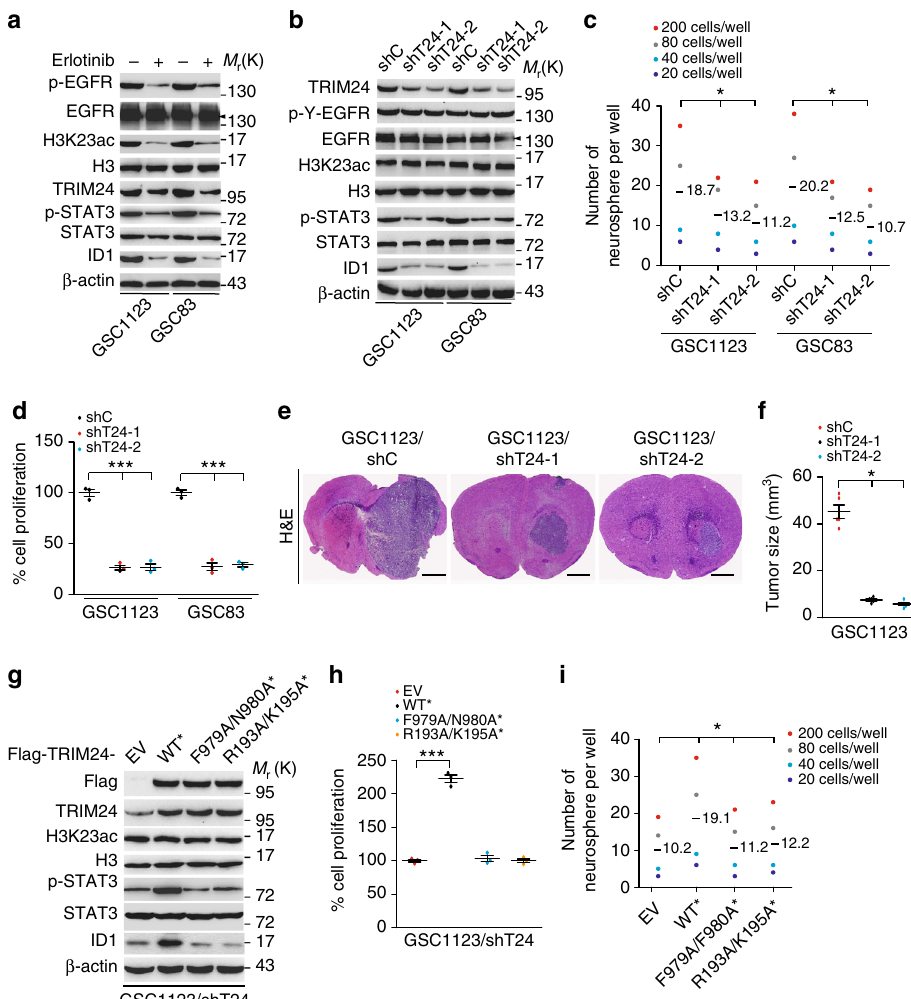
Fig. 8 H3K23ac/TRIM24/STAT3-ID1 axis mediates EGFRvIII-driven glioma stem cell proliferation and self-renewal. a Effects of EGFRvIII on expression of H3K23ac, TRIM24, ID1, STAT3 and p-STAT3. GSC1123 and GSC83 GSCs were treated with Erlotinib (10 μ M) for 24h. β -Actin, EGFR or p-EGFR was used as a control. Arrow heads, EGFRvIII. b Knockdown of TRIM24 inhibits ID1 expression and STAT3 phosphorylation, but not H3K23ac expression, in GSC1123 and GSC83 GSCs. c Limiting dilution neurosphere-forming assays measuring the effects of TRIM24 knockdown. d Cell proliferation assays of effects of TRIM24 knockdown. e Representative images of H&E, analyses of brain sections, with indicated GSC1123 GSCs. Images represent results of 5 mice per group of 2 independent experiments. Scale bars: 1mm. f Quanti fi cation of tumor size. Data were from stained brain sections of 5 mice per group of 2 independent experiments. g , h Effects of re-expression of Flag-TRIM24 shRNA-resistant TRIM24 WT* , TRIM24 F979A/N980A* mutant, TRIM24 R193A/K195A* mutant or an empty vector control (EV) on expression of H3K23ac, STAT3, ID1 and p-STAT3 ( g ) and cell proliferation ( h ) in GSC1123/shT24 GSCs. i Limiting dilution neurosphere-forming assays of effects of re-expression of Flag-TRIM24 shRNA-resistant TRIM24 WT* , TRIM24 F979A/N980A* mutant, TRIM24 R193A/K195A* mutant or an empty vector control (EV) on GSC1123/shT24 GSCs. Error bars, s.d. Data represent two or three independent experiments with similar results. * P < 0.05, *** P < 0.001, paired two-way Student ’ s t -test, compared with GSC cells or tumors treated with shC or Fig. 7a and b). Overexpression of Flag-tagged ID1 rescued STAT3 inhibitor cryptotanshinone (CTN) 39 treatment inhibited TRIM24 shRNA-inhibited cell proliferation and colony formation STAT3 phosphorylation, TRIM24 protein and TRIM24 mRNA in soft agar in LN229/EGFRvIII GBM cells (Supplementary expression, but not EGFR/EGFRvIII expression and phosphor- Fig. 7c – e). To further assess the role of TRIM24 as a ylation. STAT3 knockdown with two different shRNAs also transcriptional co-activator of STAT3, we performed ChIP- inhibited TRIM24 protein (Supplementary Fig. 6c) and TRIM24 quantitative-PCR (ChIP-qPCR) on ID1 using antibodies directed against TRIM24, STAT3 and H3K23ac to measure binding to the promoter of ID1 in LN229 GBM cells with or without EGFRvIII. As shown in Fig. 6c, TRIM24, STAT3 and H3K23ac all could bind to the ID1 promoter. Compared with the control (P/shC), EGFRvIII signi fi cantly increased the binding of TRIM24, STAT3 and H3K23ac with ID1 promoter. Knockdown of TRIM24 markedly impaired EGFRvIII-stimulated TRIM24, H3K23ac and STAT3 binding with ID1 promoter (Fig. 6c). Moreover, re-expression of shRNA-resistant TRIM24 wild type (WT*)